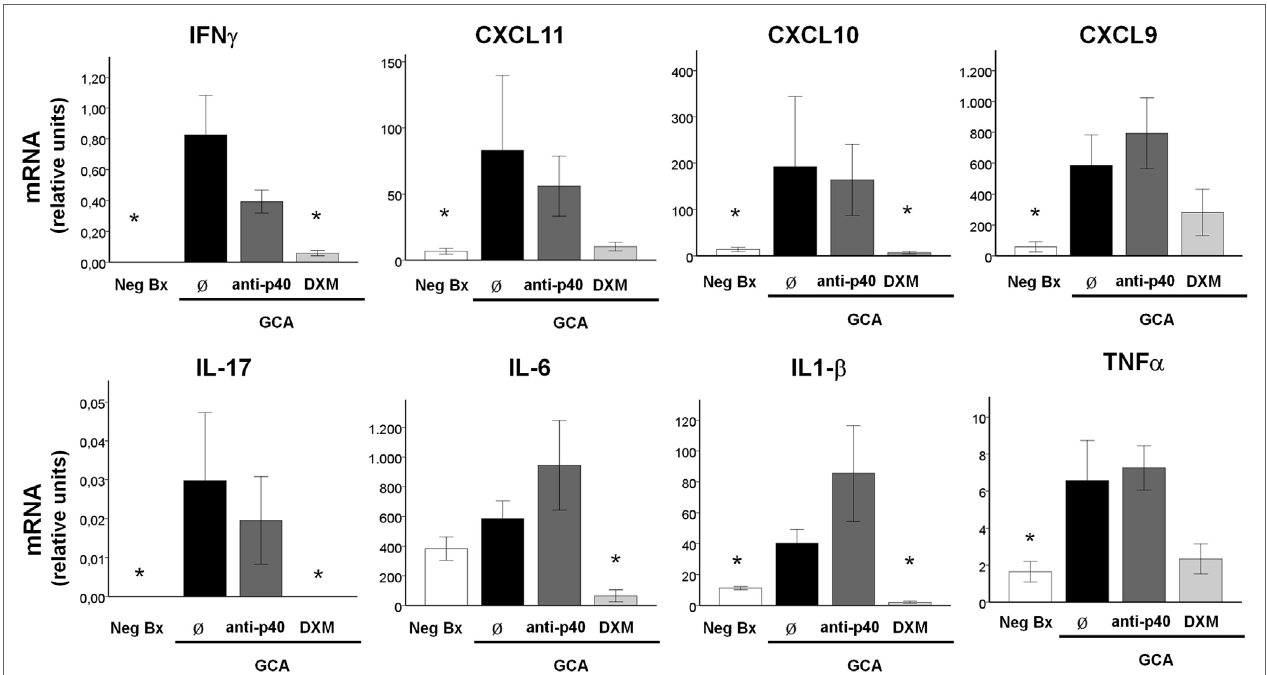
FigUre 6 | Changes in gene expression by blocking IL-12/23p40 on cultured GCA biopsies. mRNA concentrations of IFN γ , CXCL11, CXCL10, CXCL9, IL-17, IL-6, IL-1 β , and tumor necrosis factor α in 10 cultured control arteries (negative biopsies, Neg Bx) vs 10 cultured GCA-involved arteries untreated or exposed to anti-human IL-12p40 mouse monoclonal Ab (anti-p40) (10 µg/ml), or dexamethasone (DXM) (0.5 µg/ml). Statistical comparisons were performed between histologically negative and GCA-involved arteries and between GCA-involved arteries and anti-p40 treated and DXM treated. Bars represent mean ± SEM, * p <